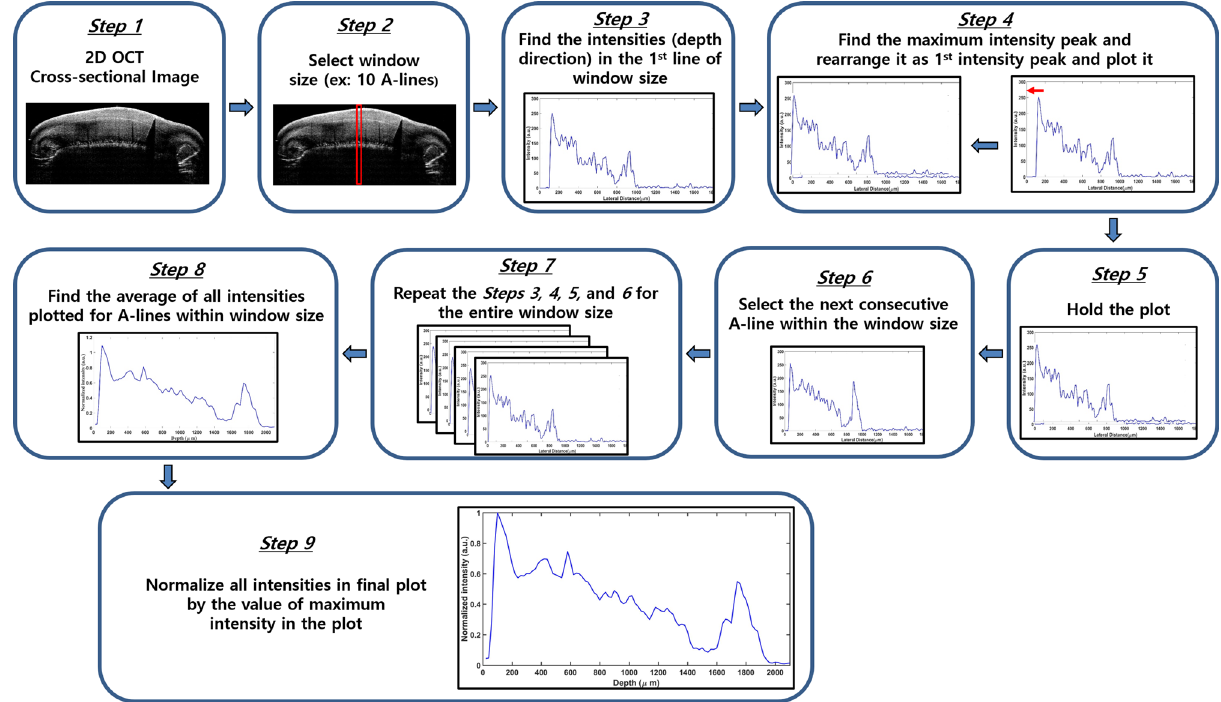
Figure 2. Flow diagram of depth intensity profile analysis